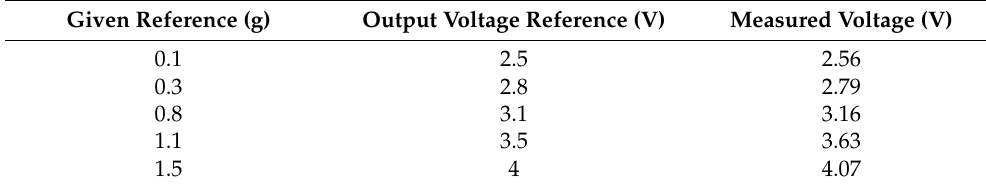
Table 3. Accelerometer reference and measured values on the experimental setup. Given Reference (g)